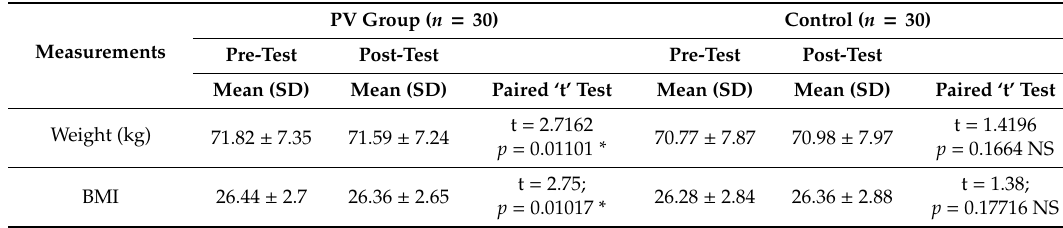
Table 3. Anthropometric